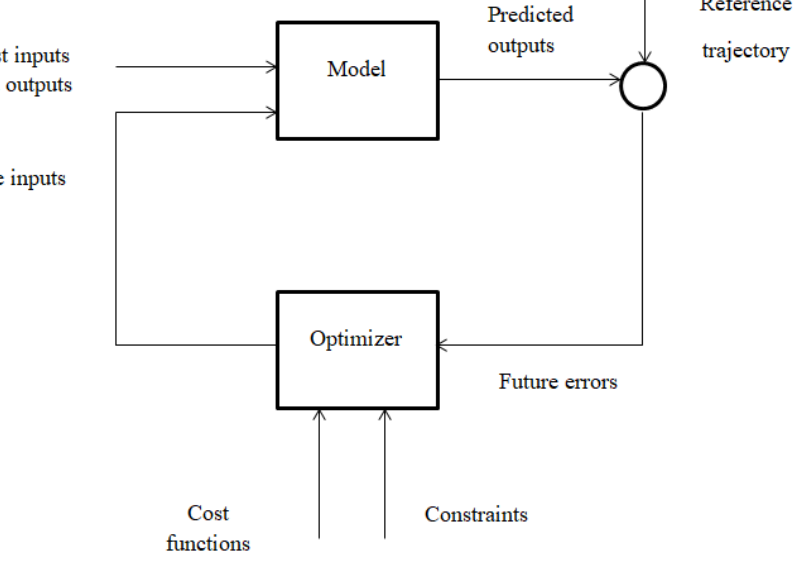
Figure 6. Basic structure of